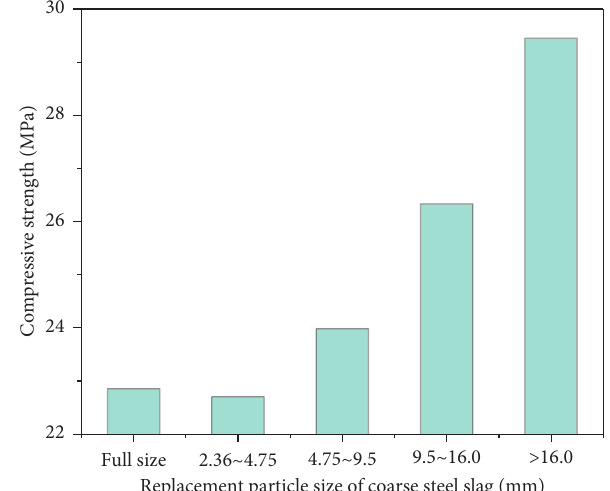
Figure 12: The impact of the replacement particle size of coarse steel slag on the compressive strength of the FSSAC.